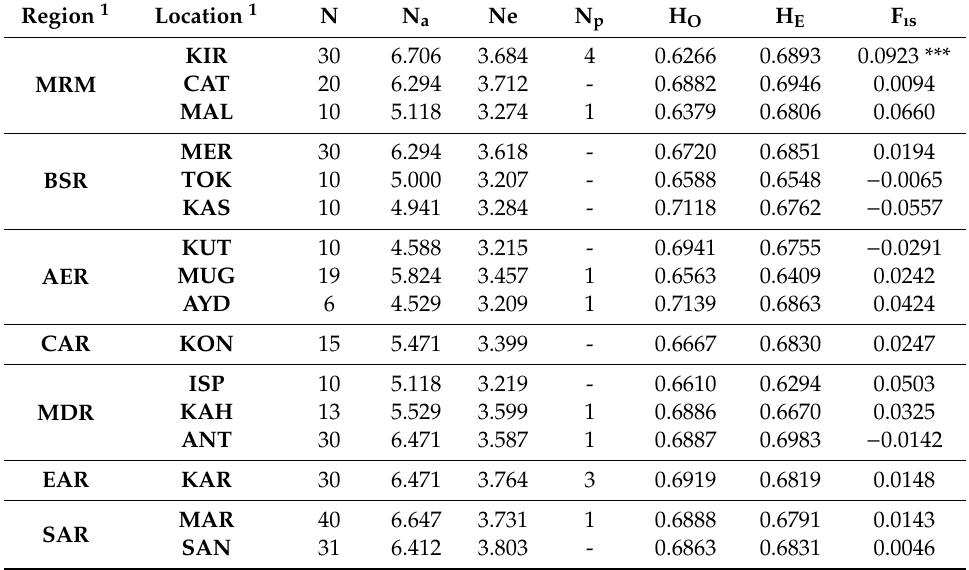
Table 3. Main diversity parameters from each Turkish donkey populations included in this study for a panel of 17 microsatellite markers: the number of individuals (N), the mean number of alleles (N a ), the number of e ff ective alleles (N e ), the number of private alleles (N p ), observed heterozygosity (H o ), unbiased expected heterozygosity (H e ) and deficit of heterozygotes (F IS